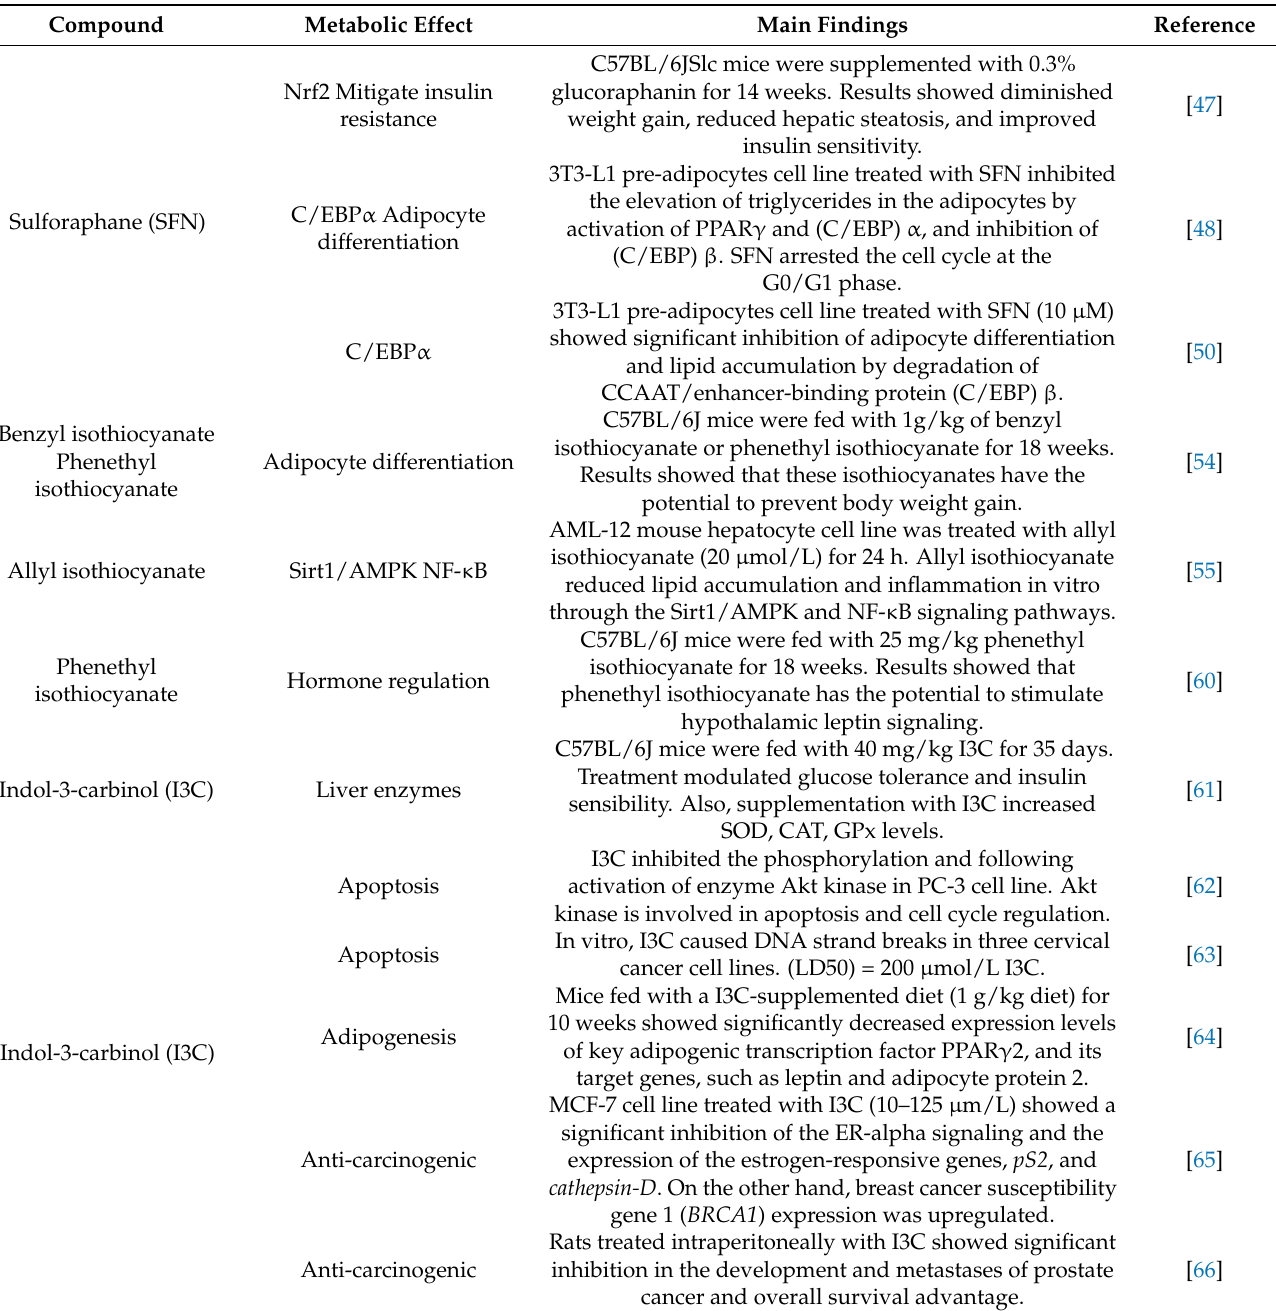
Table 2. Health benefits of isothiocyanates (ITC) found in kale, determined through in vivo and in vitro studies.